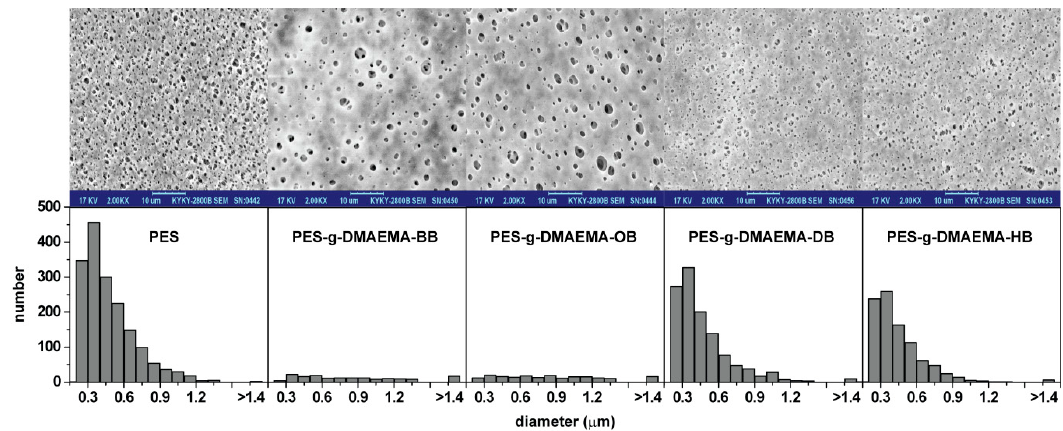
Figure 4. SEM images and pore size distribution of the surface of various membranes.